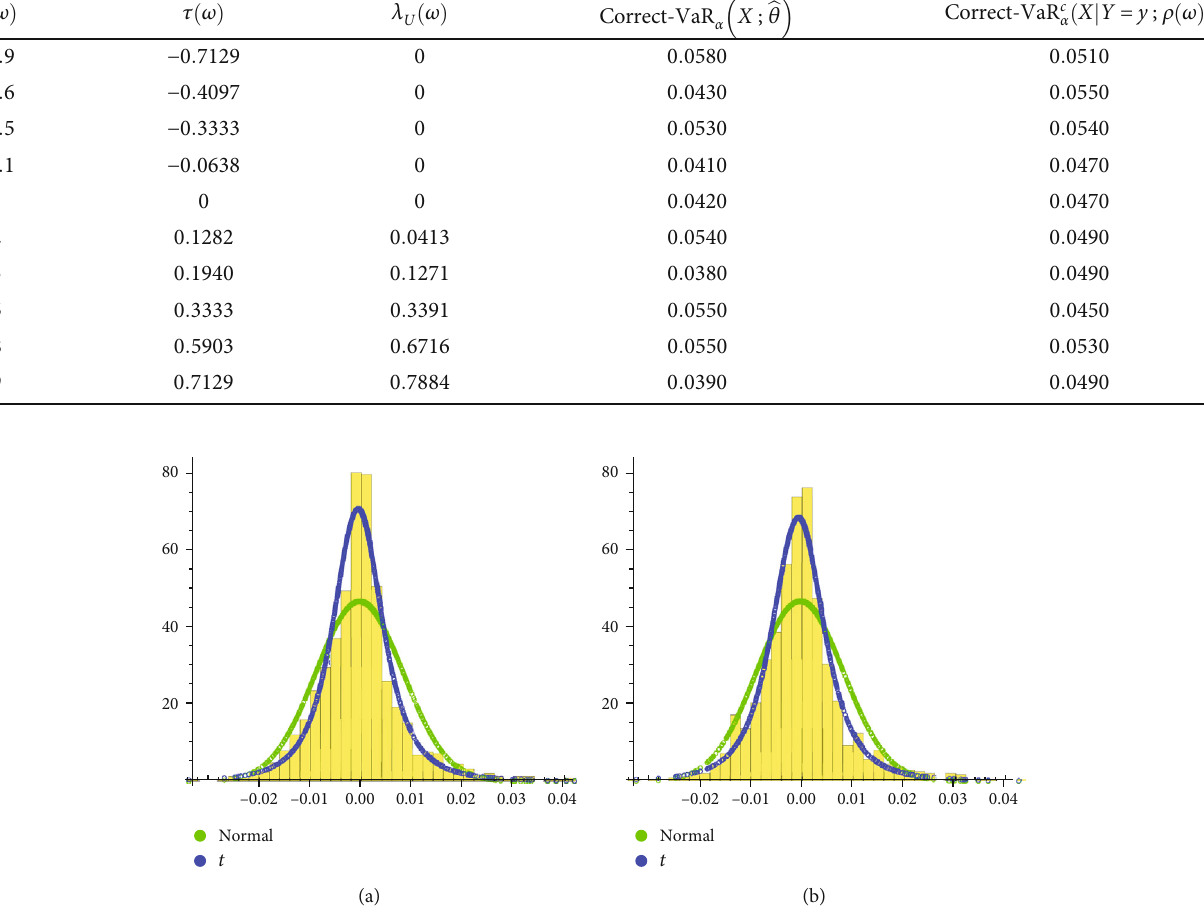
Figure 12: Histogram of the negative daily log-returns of the S&P 500 (a) and Dow Jones (b); each data set fi ts to the t distribution (represented by the blue probability function) better than the normal distribution (represented by the green probability function).